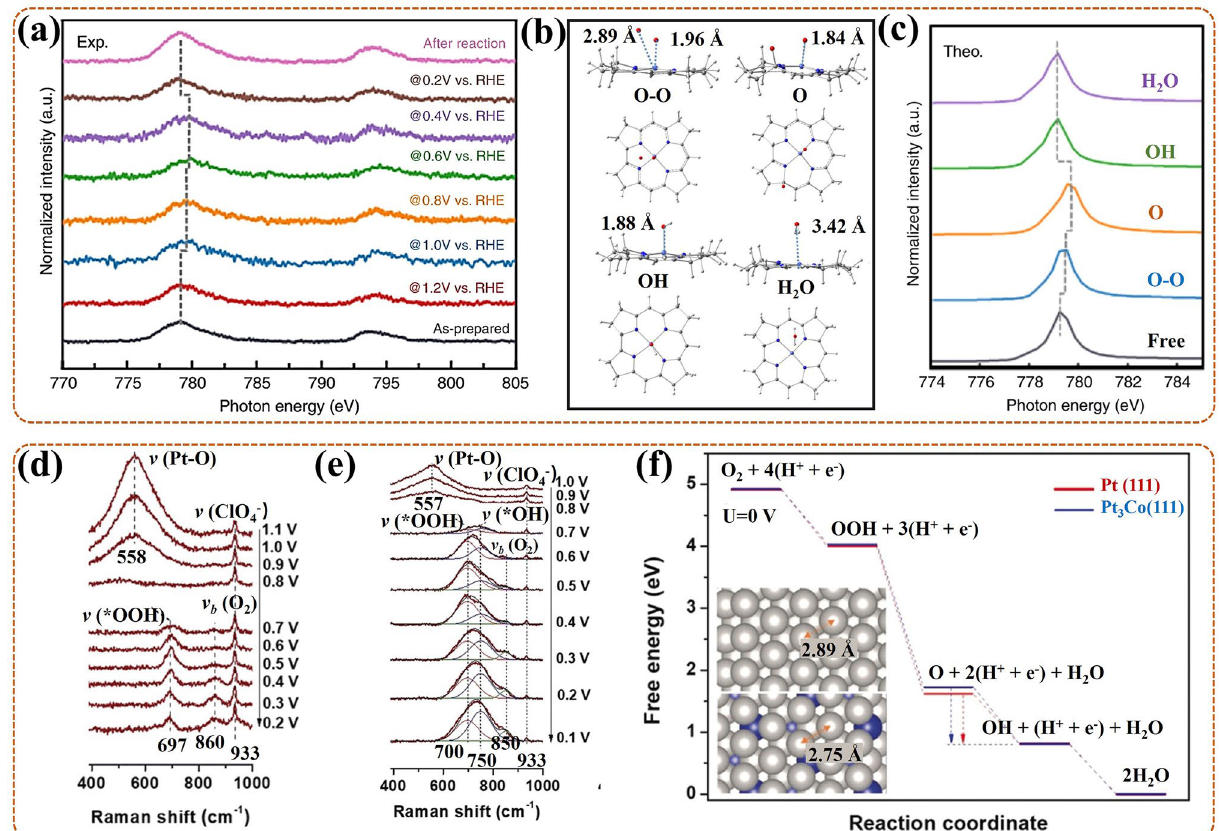
Fig. 14 a In-situ Co L 3,2 -edge XANES spectrum of py-B12/C catalyst at different potentials; b Optimized structures for OO, O, OH, and H 2 O models of four-electron pathway; c FEFF8 calculated Co L 3,2 -edge XANES spectrum with different oxygenated intermediates [145]; Reused with approval; Copyright 2020 Nature. In-situ EC-SHINERS spectra of Pt 3 Co during ORR in O 2 saturated in d 0.1 M HClO 4 , or e 0.1 M NaClO 4 + 1 mM NaOH; f At U = 0 V, the Gibbs Free Energy plots of each ORR steps on the Pt 3 Co (111) (blue) and Pt (111) (red), with their atomic models in the left bottom inset [140]. Reused with approval; Copyright 2019 WILEY-VCH Verbg GmbH&Co. KGaA, Weinheim.